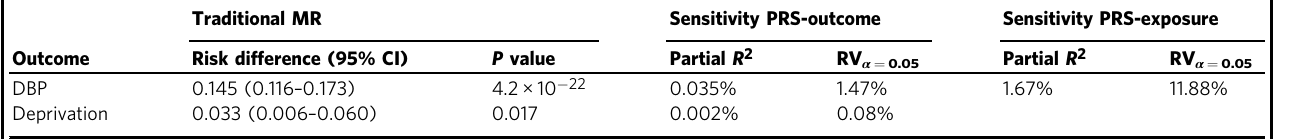
Table 1 Traditional MR results and sensitivity